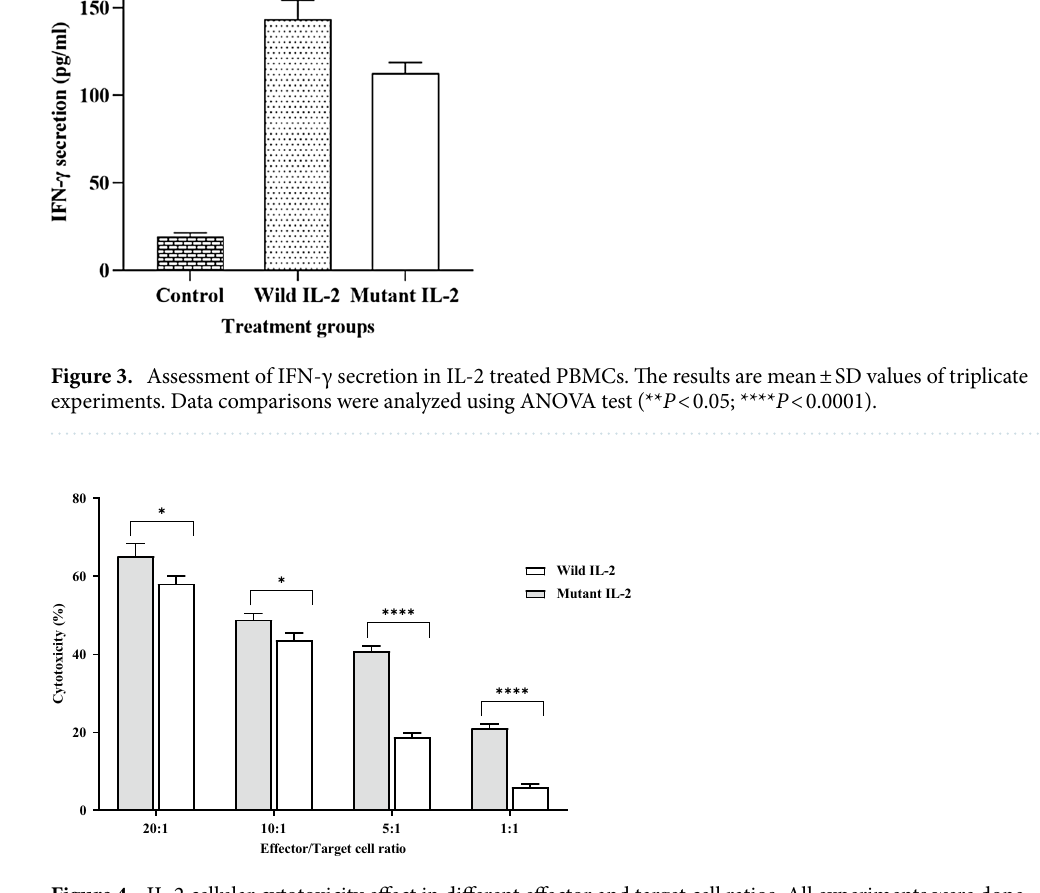
Figure 4. IL-2 cellular cytotoxicity effect in different effector and target cell ratios. All experiments were done in triplicate. Data analysis was done with t-test and represented as mean ± SD (* P < 0.03; **** P <